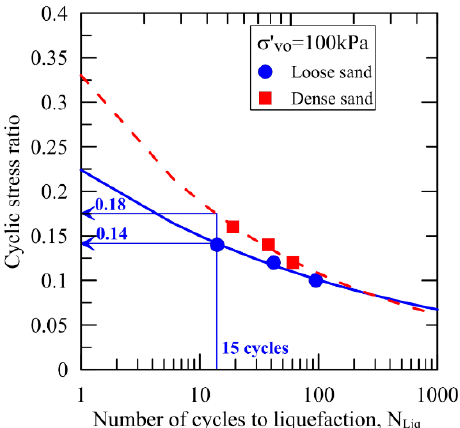
Figure 4. Relationship of number of cycles to liquefaction ( N liq ) and cyclic stress ratio ( CSR ) from cyclic direct simple shear (CDSS) test results under σ ´ v0 = 100 kPa.